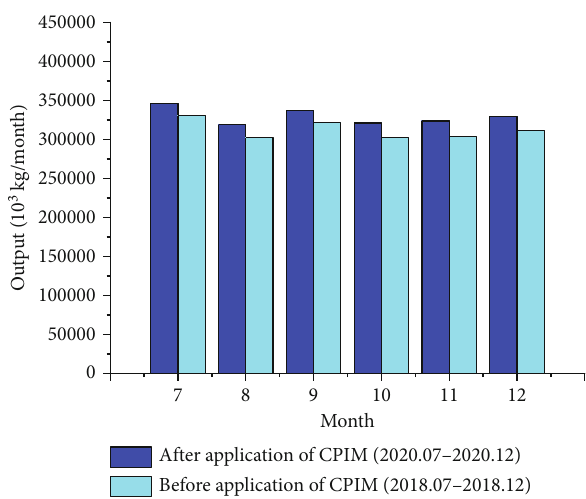
Figure 13: Variation of the total output with time for di ff erent